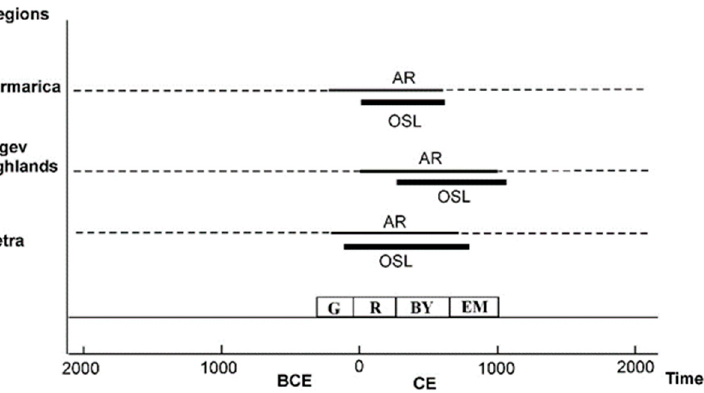
Figure 17. Operation time of large-scale terrace farming in different locations in the arid Southern Levant. Solid line—timing according to Archeological Surveys (AR). Thick solid line—timing according to OSL dating. Dashed lines—minor construction and utilization of arid terrace farming. Here, G is Greek era, R is Roman era, BY is Byzantine era, and EM is the early Muslim era.